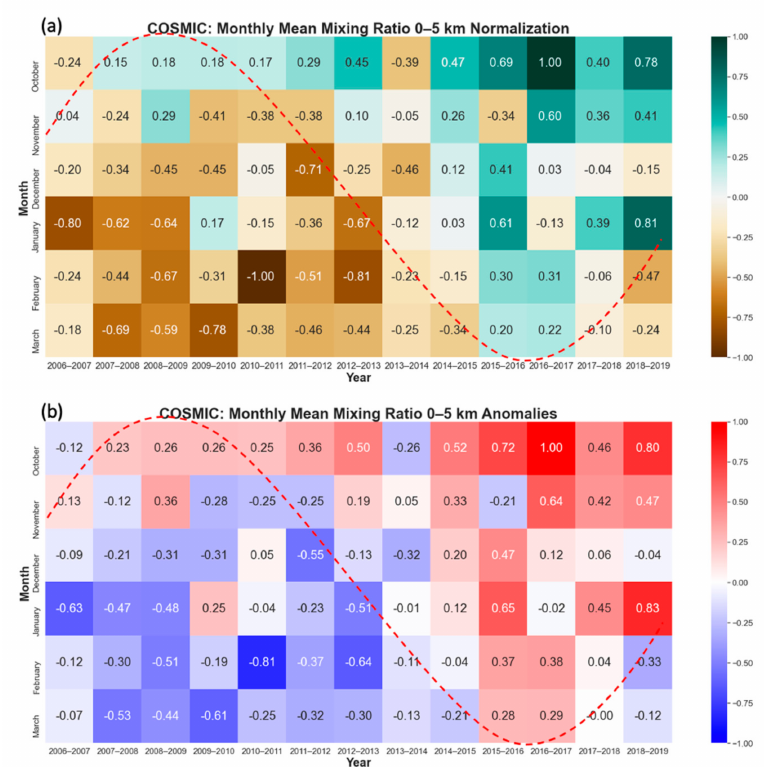
Figure 3. COSMIC mixing ratio heatmaps: ( a ) 0–5 km normalization and ( b ) 0–5 km anomalies. The second COSMIC variable that was investigated was the 0–5 km (i.e., lowest level to 5 km above ground level (AGL)) temperatures (Figure 4). Similar to patterns seen in the moisture field, temperatures in the domain decreased by ~ − 2.10 °C (~ − 0.52 ◦